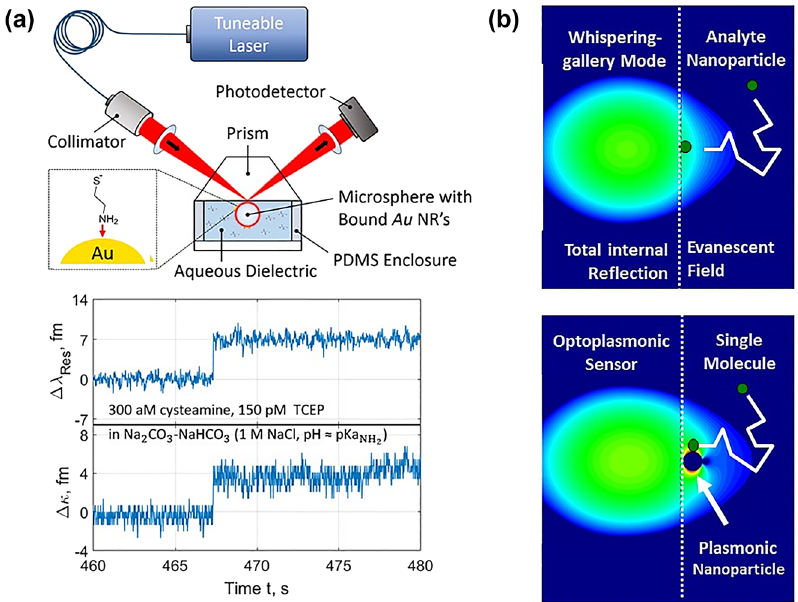
Figure 17: (a) TOP: An optoplasmonic sensor combines the light recirculation in a high Q ( Q ∼ 10 6 − 7 ) whispering-gallery mode (WGM) micro- sphere cavity with the plasmonic near fi eld enhancements of gold (Au) nanorods (NRs) that are attached to the microcavity. BOTTOM: Optoplasmonic sensor signals that were recorded for individual cysteamine ( ∼ 77 Da) molecules binding to the Au NRs. Binding events are detected from femto-meter step-changes in the resonance wavelength or linewidth traces. The detection sensitivity of 300 aM cysteamine required speci fi c buffer conditions, adapted from [147]. (b) TOP: Dielectric WGM cavity sensing mechanism. The WGM resonance changes as single (analyte) nanoparticles diffuse and bind to the dielectric WGM sensor within its evanescent fi eld where the WGM interacts with the nanoparticle,adaptedfrom[330].BOTTOM:Optoplasmonic WGMsensingmechanism.Aplasmonicnanoparticleattachedto theWGMsensor and excited by the WGM near the plasmon resonances frequency enhances the intensity of the probing light fi eld at the surface of the nanoparticle. Single molecules are detected with much higher sensitivities if they bind within the region of plasmonic near- fi eld enhance- mentswhere,dependingontheplasmonicnanoparticleorsystem,thewavelengthshiftcanbegreatlyenhancedbyafactorof10 3 – 10 4 overthe shift expected for an all-dielectric microsphere sensor, adapted from